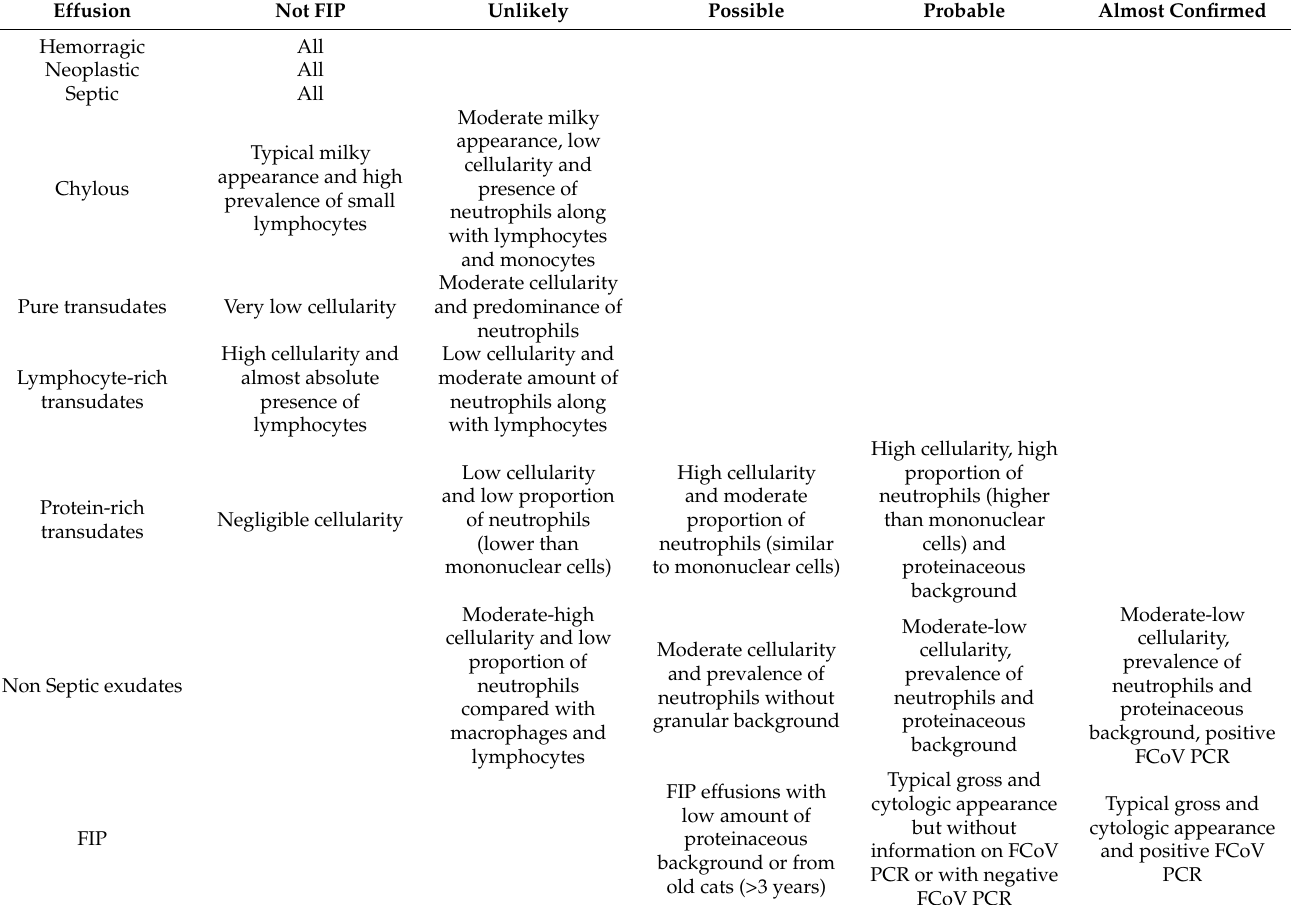
Table 2. Probability of FIP based on results of